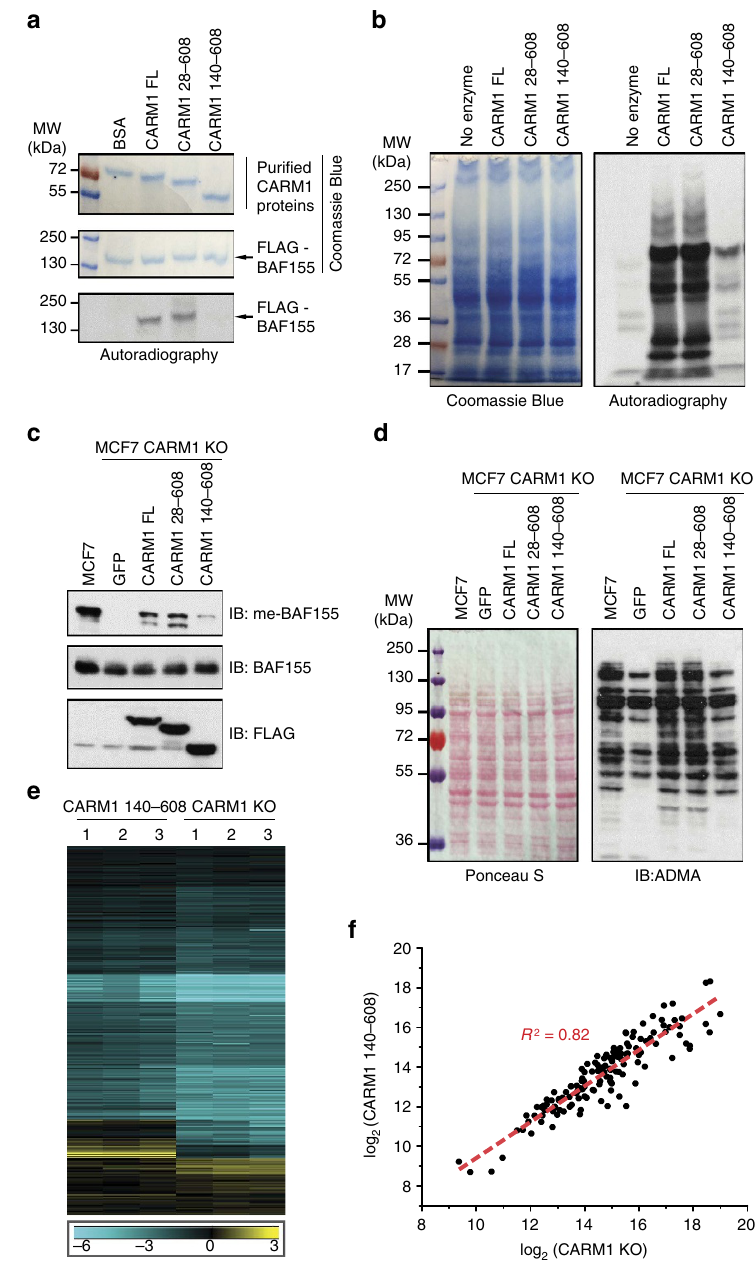
recombinant CARM1 proteins and 3 H-SAM to test methylation of FLAG-BAF155 protein. Coomassie Brilliant Blue staining of purified BSA (control),